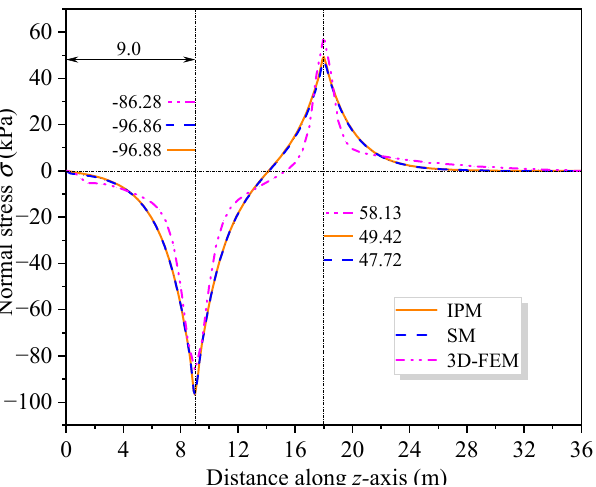
Figure 13. Distribution curve of normal stress at the flange top along the beam axis: ( a ) Case 1; ( b ) Case 2.